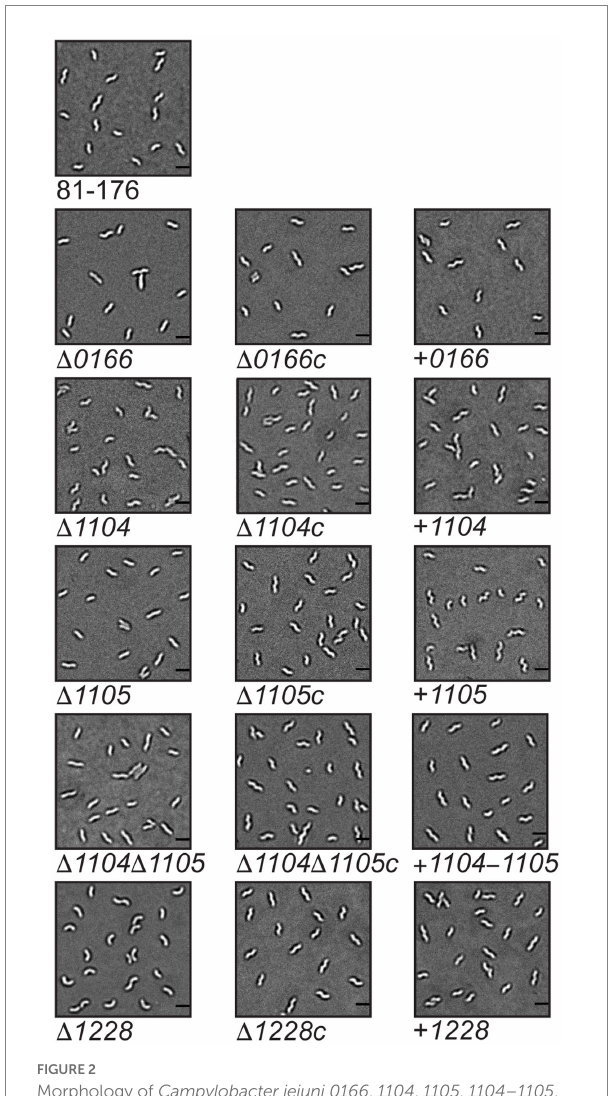
FIGURE 2 Morphology of Campylobacter jejuni 0166 , 1104 , 1105 , 1104 – 1105 , and 1228 mutant, complement, and overexpressor strains. DIC microscope images of the helical Campylobacter jejuni 81-176 strain, the ∆ 0166 , ∆ 1104 , ∆ 1105 , ∆ 1104 , ∆ 1105 , and ∆ 1228 mutant strains and corresponding complemented ( ∆ 0166c , ∆ 1104c , ∆ 1105c , ∆ 1104 , ∆ 1105c , and ∆ 1228c) and overexpression strains (denoted + 0166 , + 1104 , + 1105 , + 1104 – 1105 , and + 1228 ). The scale bar indicates 2 μ